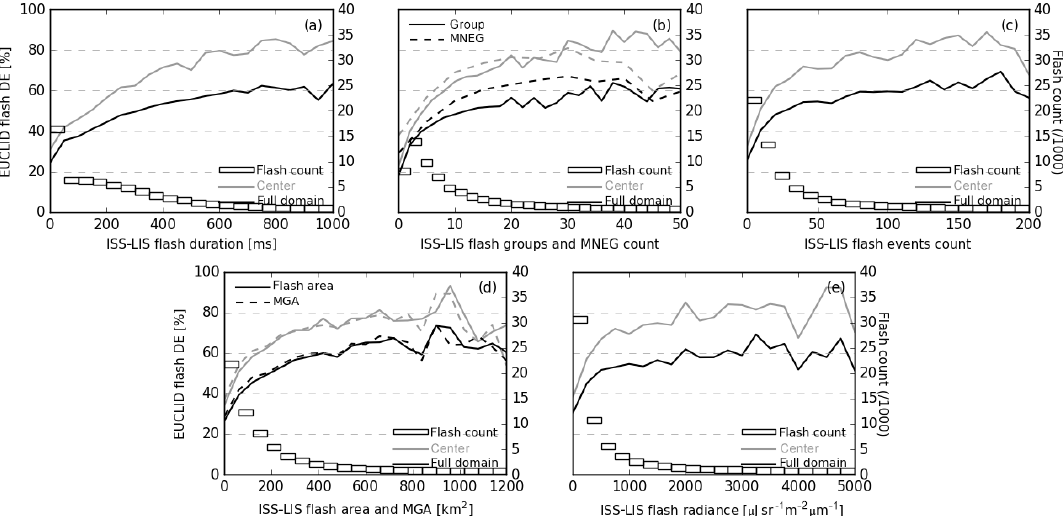
Figure 8. The distribution of EUCLID relative flash DE as a function of ISS-LIS flash characteristics is plotted. These characteristics include (a) flash duration, (b) number of groups in flash and maximum number of events in a group, (c) number of events, (d) flash area and maximum group area, and (e) flash radiance. Black lines are the results for the full domain, whereas gray lines are related to the center of EUCLID. Additionally, the ISS-LIS flash counts per interval are plotted as well.